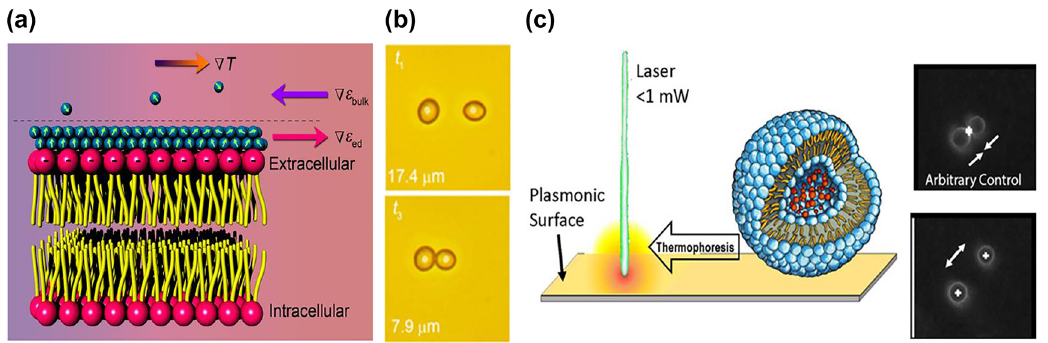
Figure 6: Optothermal trapping of biological